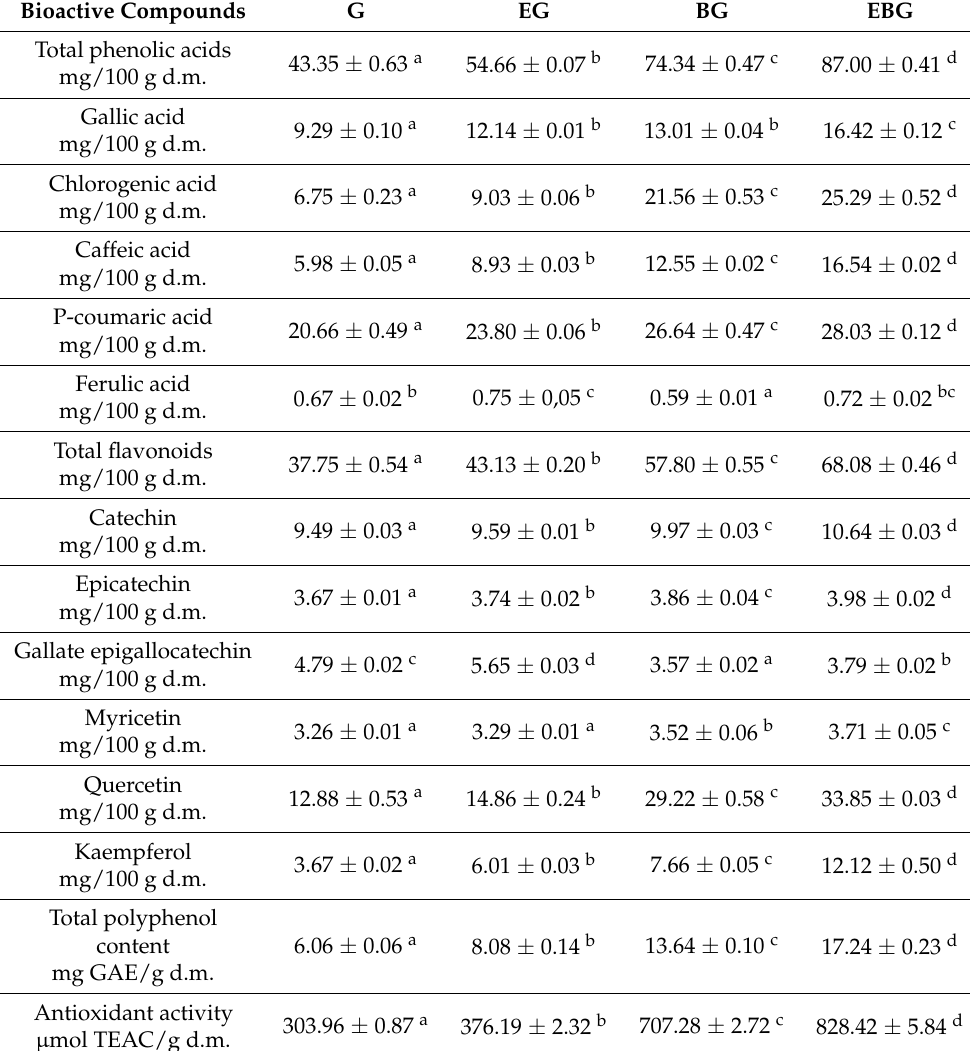
Values are means ± standard deviation (n = 3). a–d —different letters in the same line are significantly different (Duncan’s test, p < 0.05). G—conventional white garlic; EG—organic white garlic; BG—conventional black garlic; EBG—organic black